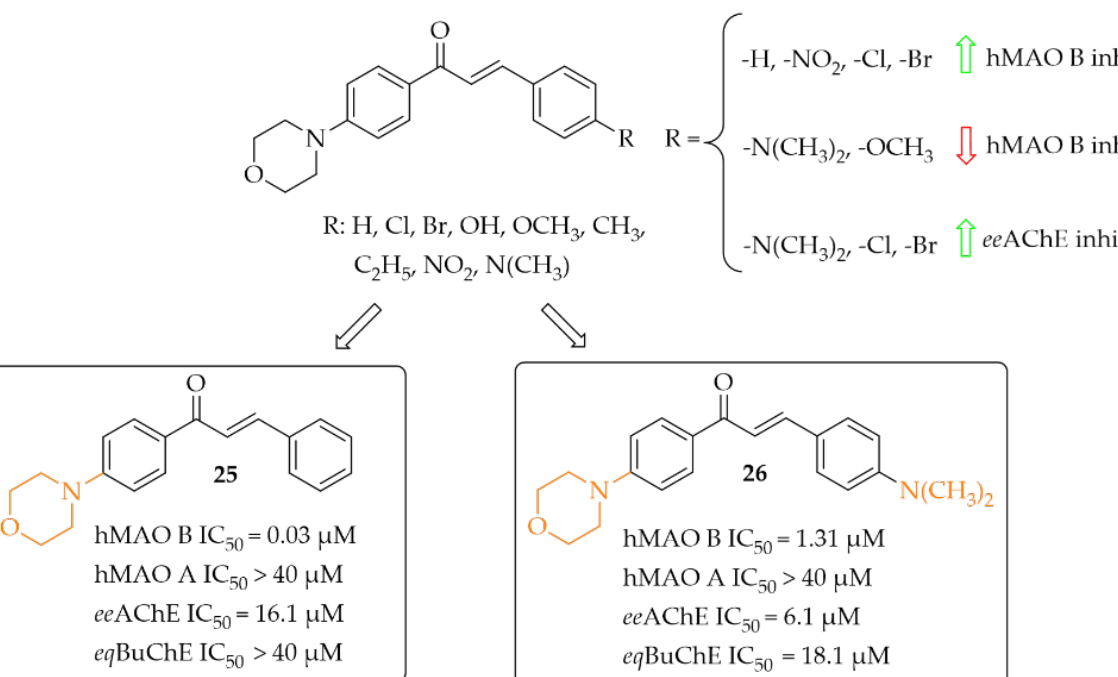
Figure 19. Morpholine-based chalcones and the most potent compounds in the series [45]. Aldoxime Ethers